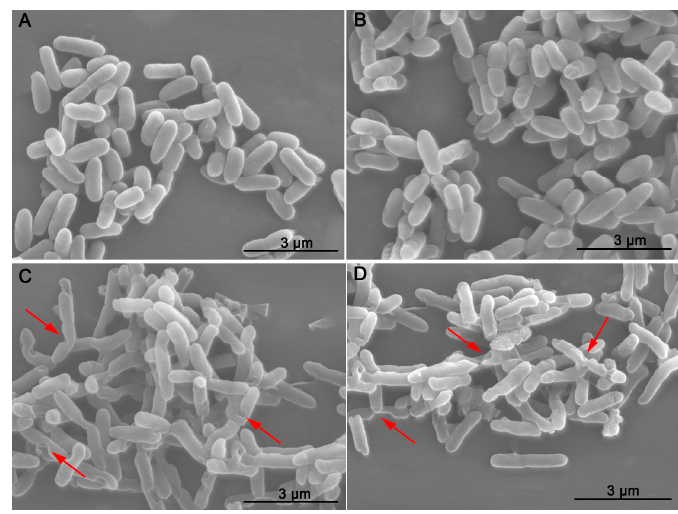
Figure 3. SEM images of R. solanacearum cells treated with PCA at different concentrations. ( A ) Untreated cells; ( B ) Cells treated with DMSO alone at a final concentration of 1%; ( C ) Cells treated with 30 μ g/mL PCA; ( D ) Cells treated with 40 μ g/mL PCA. Cells were incubated for 12 h with shaking at 180 rpm at 30 °C.